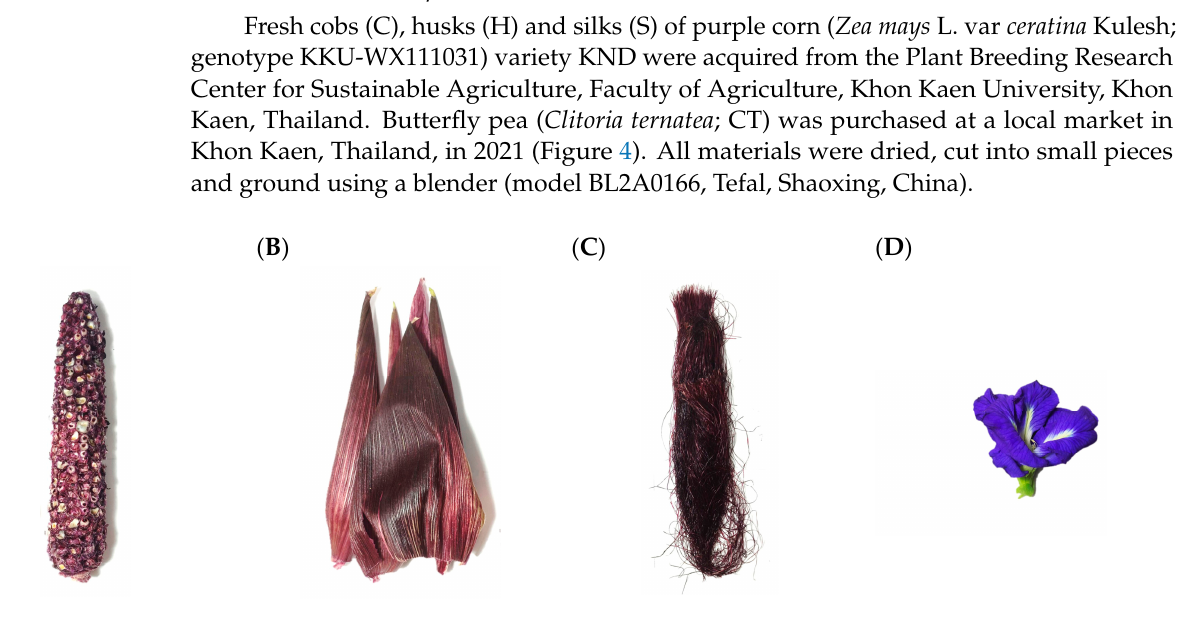
Figure 4. Raw materials: ( A ) KND cob, ( B ) KND husk, ( C ) KND silk and ( D ) butterfly pea.